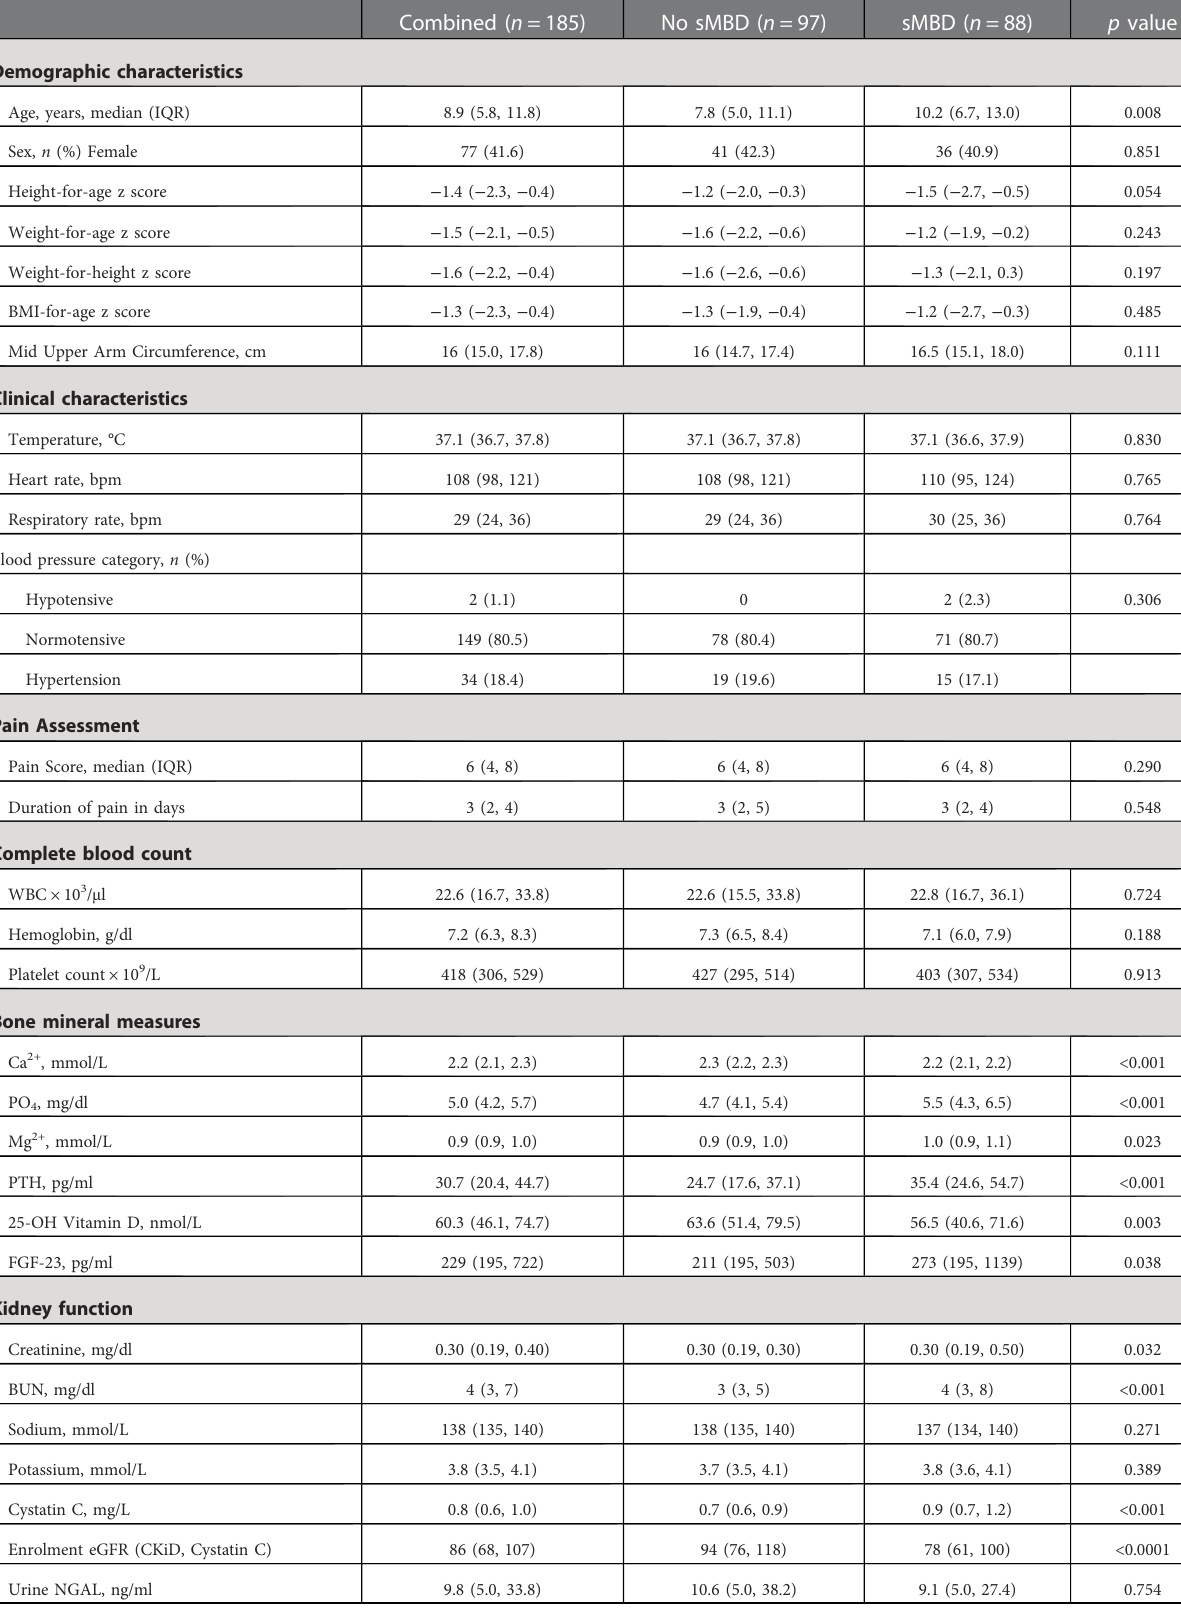
TABLE 1 Demographic, clinical and laboratory characteristics on admission associated with bone mineral